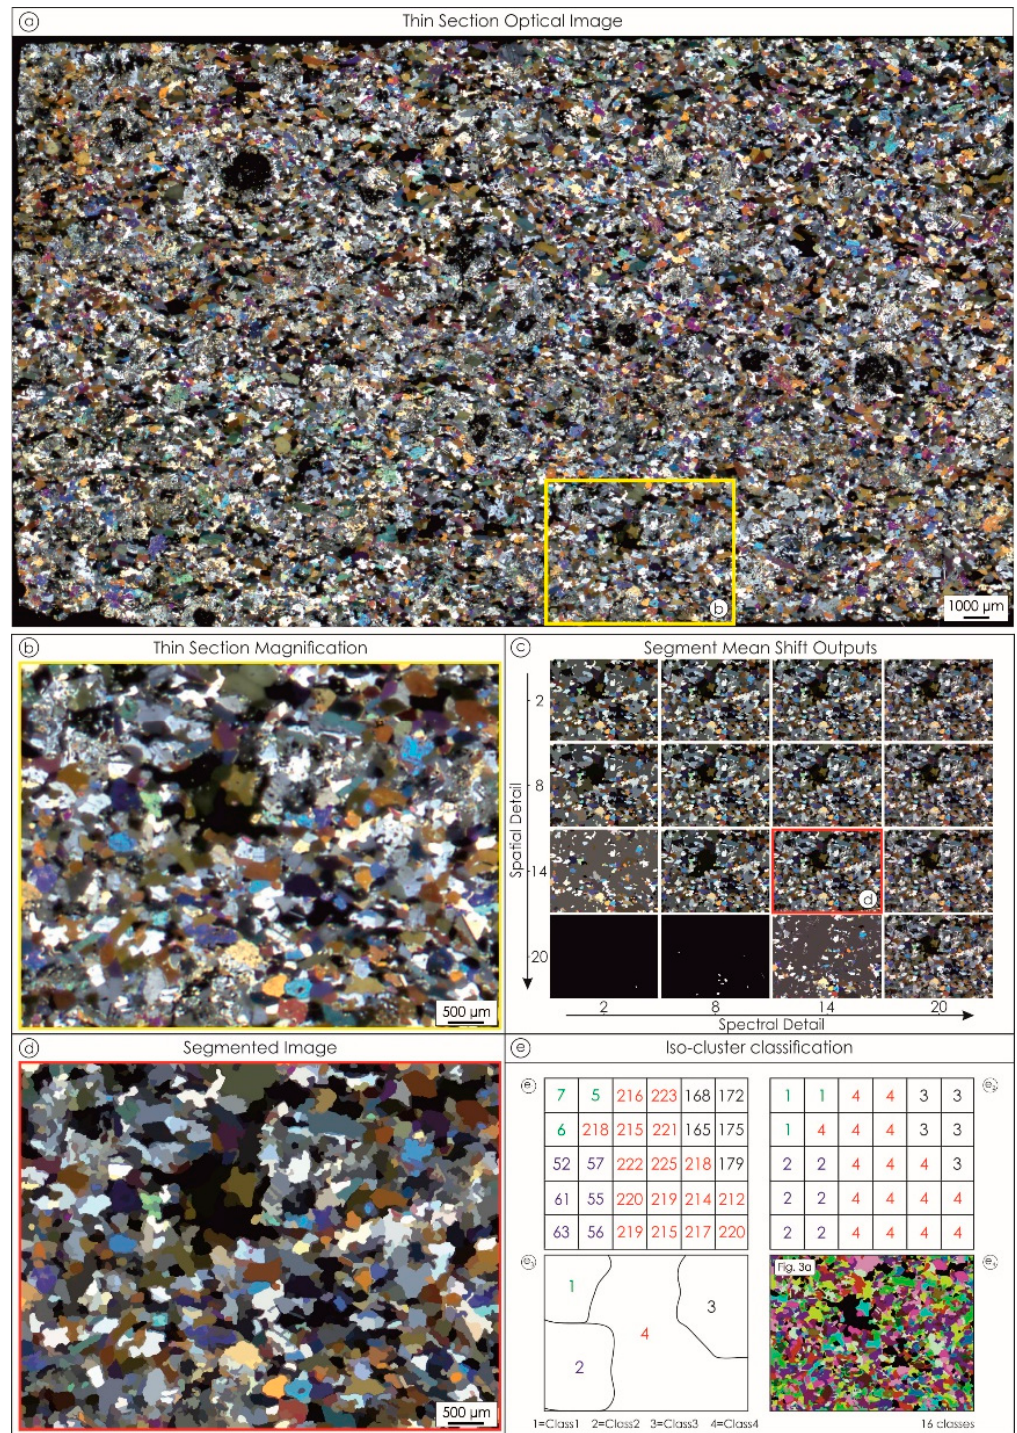
Figure 3. GSD tool segmentation steps: ( a ) the thin section optical image (39.1 × 23.1 mm 2 in size with a pixel size of 5.29 μ m). Inset represents Figure 3b; ( b ) magnification of the thin section; ( c ) the outputs of the Segment Mean Shift algorithm at different settings of spatial and spectral detail parameters; ( d ) the segmented image obtained with values of 14 for both spatial and spectral details; ( e ) ( e 1 – e 3 ) schematization of the iso-cluster classification by choosing four classes: ( e 1 ) the pixel color intensities of the segmented image. Colored numbers are used to emphasize groups of pixels with similar color intensities; ( e 2 ) the result of the clustering process applied to the single pixel; ( e 3 ) the identification of classes; ( e 4 ) results obtained from the iso-cluster classification if 16 classes are given.